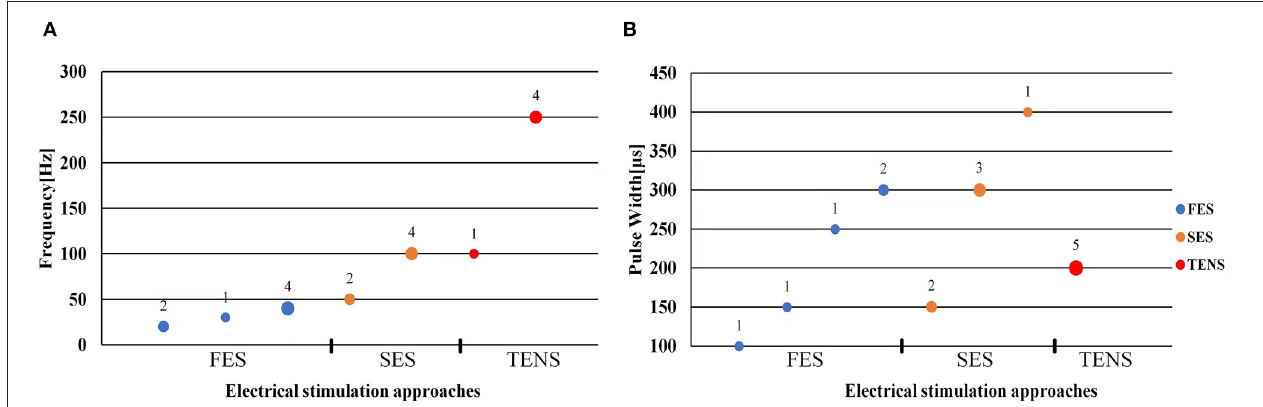
FIGURE 4 | Scatter plot of stimulation frequency (A) and pulse width (B) . Blue dots represent functional electrical stimulation (FES), yellow dots represent sensory electrical stimulation (SES) and red dots represent transcutaneous electrical nerve stimulation (TENS). The circle size and its superscript indicate the number of studies.